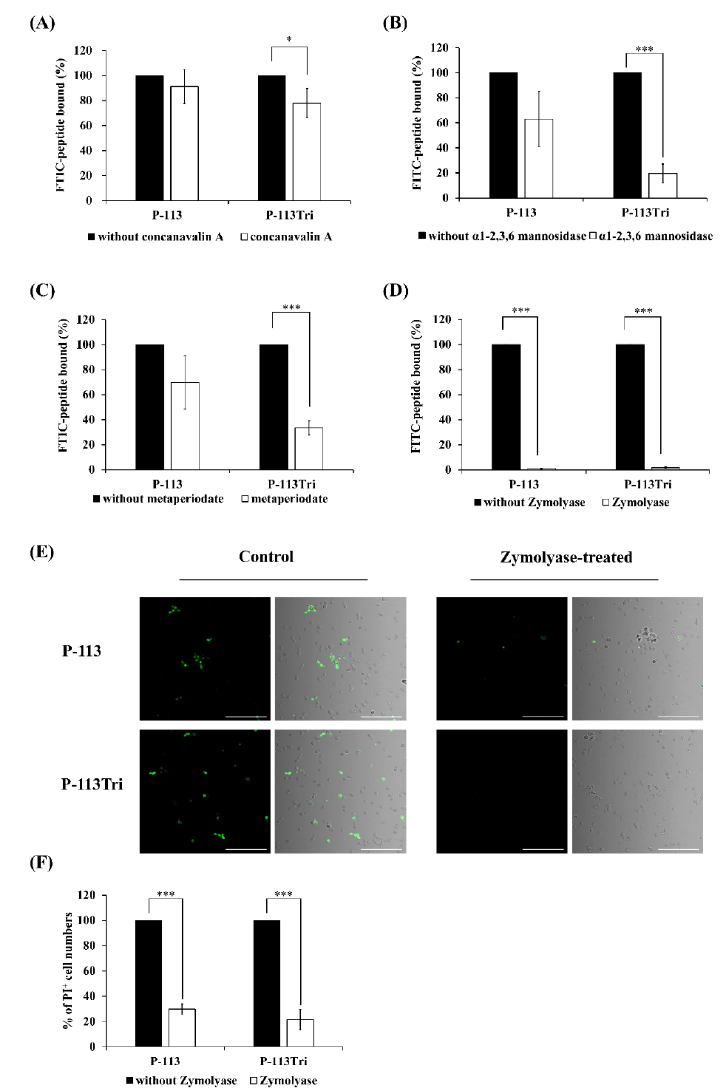
Figure 2. Effect of C . albicans cell wall modifications on the peptides cell binding and antifungal activity. ( A ) The binding of FITC-P-113 and FITC-P-113Tri to concanavalin A-treated C. albicans cells. C. albicans were treated with concanavalin A (100 µ g / mL) at 30 ◦ C for 1 h and then incubated with the peptides (0.6 µ g / mL). ( B ) The binding of FITC-P-113 and FITC-P-113Tri to α 1-2,3,6 mannosidase-treated C. albicans . Cells were treated with α 1-2,3,6 mannosidase (5.0 U) at 37 ◦ C for 16 h and then incubated with the peptides (0.6 µ g / mL). ( C ) The binding of FITC-P-113 and FITC-P-113Tri to metaperiodate-treated C. albicans . Cells were treated with metaperiodate (100 mM) for 30 min at 4 ◦ C and then incubated with the peptides (0.6 µ g / mL). ( D ) The binding of FITC-P-113 and FITC-P-113Tri to Zymolyase-treated C. albicans . Cells were treated with Zymolyase (2.5 mg / mL) for 1 h at 37 ◦ C and then incubated with the peptides (0.6 µ g / mL). ( E ) Confocal microscopic examination of the interaction of P-113 and P-113Tri with Zymolyase-treated C. albicans . Cells were treated with Zymolyase (2.5 mg / mL) for 1 h at 37 ◦ C and incubated with the peptides (0.6 µ g / mL). Scale bar, 50 µ m. ( F ) Viability of Zymolyase-treated cells with peptide treatment. C. albicans were treated with Zymolyase (2.5 mg / mL) for 1 h at 37 ◦ C and incubated with 20 µ g / mL propidium iodide (PI) and peptides (0.6 µ g /